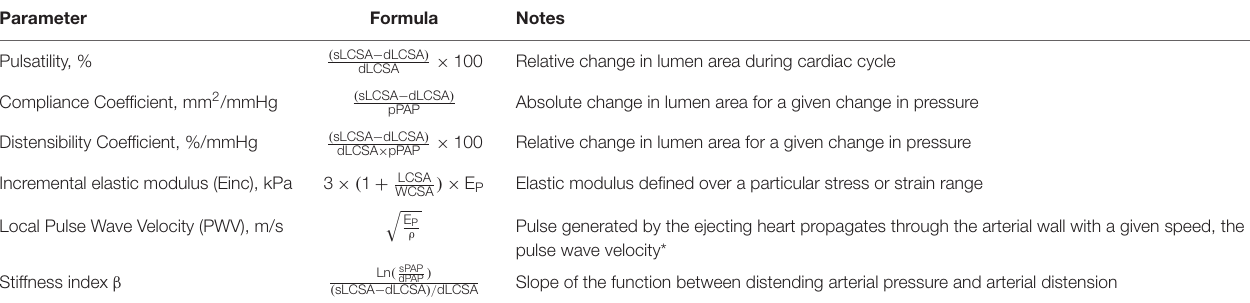
TABLE 1 | Indices of local pulmonary arterial stiffness. Parameter Formula